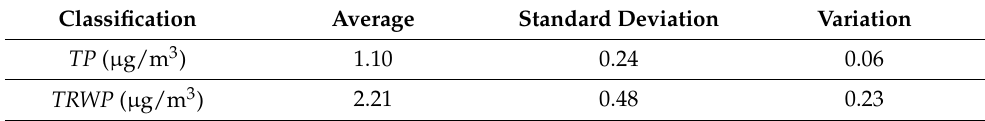
Table 2. The average concentration, standard deviation, and variation for TP and TRWP in the air.